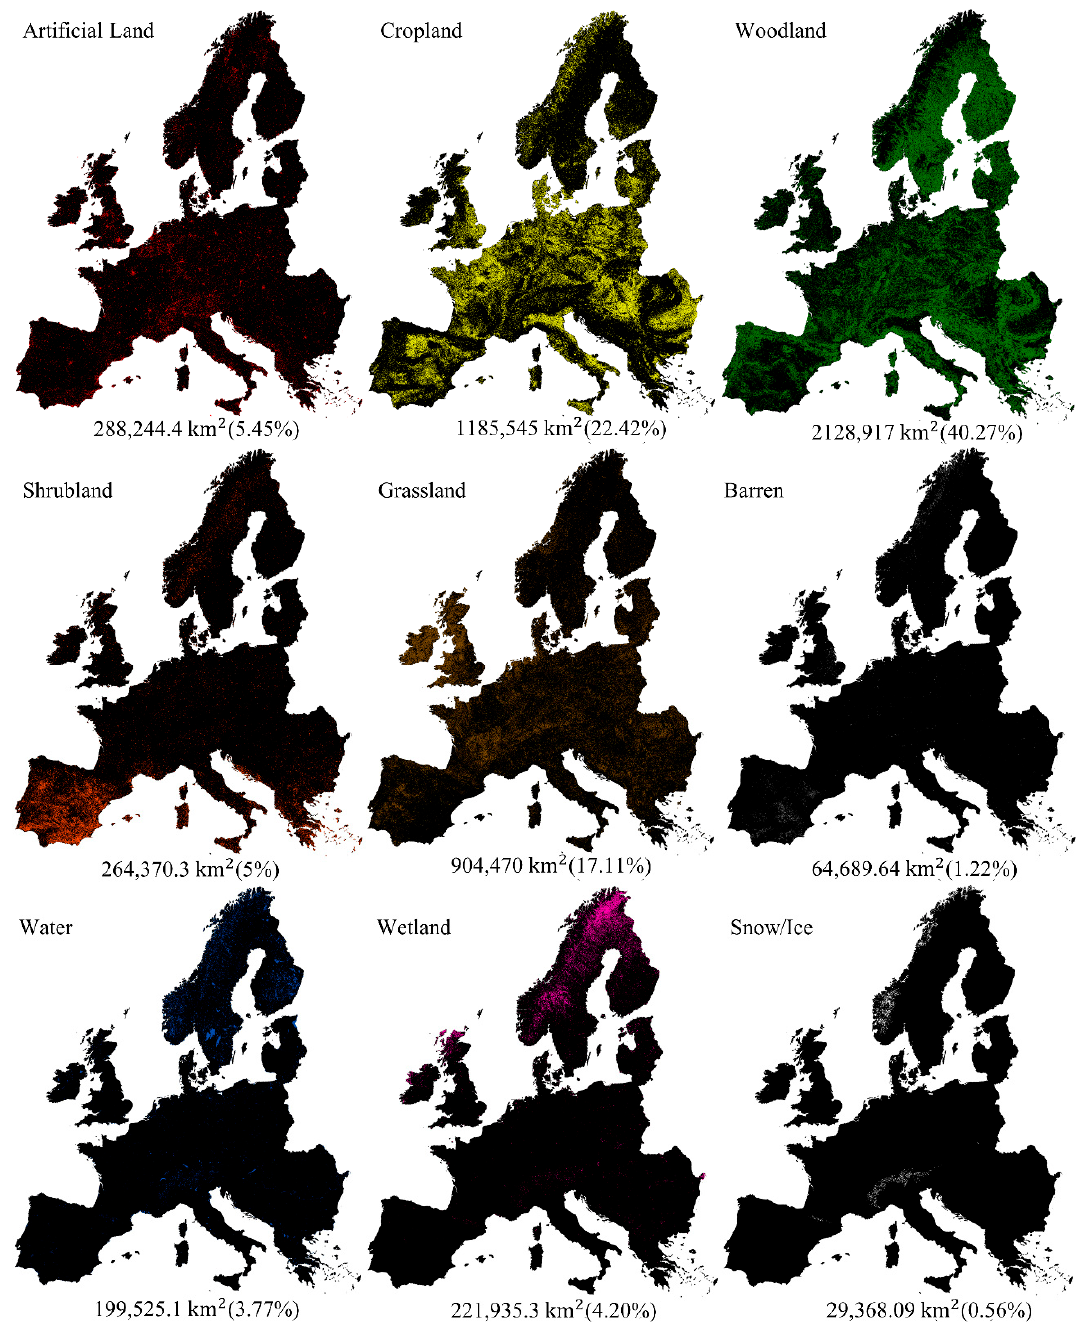
Figure 6. The binary maps and adjusted areas of all classes computed using [100,101] estimations, showing the extent of each class across the entire continent of Europe using the proposed method-